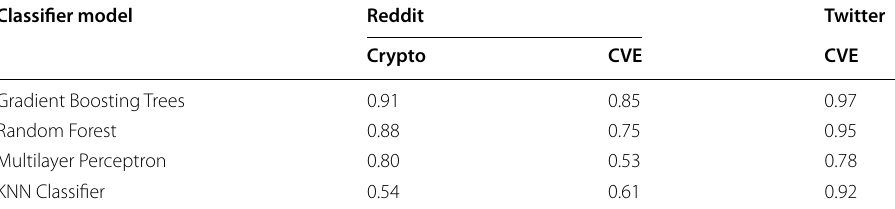
Table 2 AUC performance by various classifiers on the node placement problem Classifier